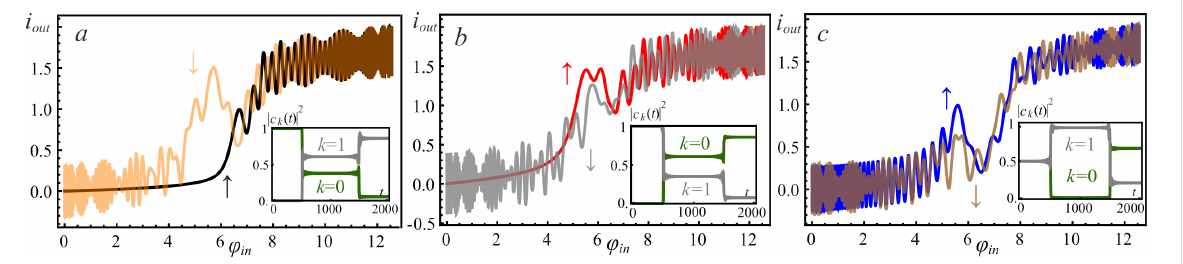
Figure 6: The activation functions of the neuron with l = 2.5 initialized (a) in the ground state, see the black “ ↑ ” and orange “ ↓ ” curves; (b) in the first excited state, see the red “ ↑ ” and gray “ ↓ ” curves; (c) in the superposition of the basis states, see the blue “ ↑ ’ and brown “ ↓ ” curves. Input flux pa- rameters are D = 0.008, A = 4 π , t 1 = 500. The symbol “ ↑ ” corresponds to the rise branch of φ in = 0 → 4 π , the “ ↓ ” symbol corresponds to the fall branch of φ in = 4 π→ 0. The inserts show the time-dependent evolution of the populations | c k ( t )| 2 of the ground state, k = 0, and the first excited, k = 1, state of the system.